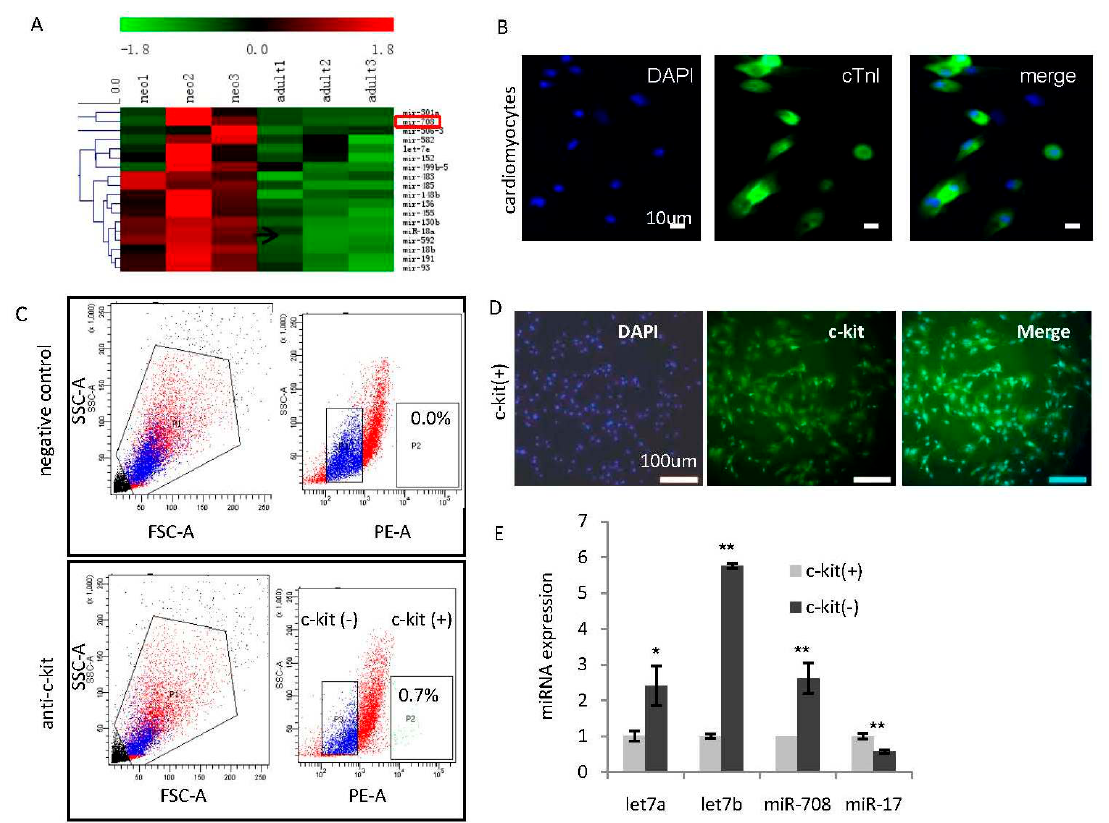
Figure 1. miR-708 is enriched in non-progenitor cardiomyocytes of neonatal rat. ( A ) miRNA profiling analyses between three neonatal and three adult heart tissues in rat identified a subset of miRNAs with higher expression in the neonatal hearts compared to adult hearts including miR-708 which is highlighted with red box; ( B ) Immunofluorescence staining of cardiomyocytes-specific marker cardiac troponin I (cTnI) in cardiomyocytes isolated from fresh heart tissues of neonatal rat; ( C ) FACS analysis isolated c-kit(+) cells from fresh hearts of neonatal rat; ( D ) Immunofluorescence staining of the isolated c-kit(+) cardiac stem cells (CSCs)/cardiac progenitor cells (CPCs); ( E ) A miRNA quantitative analysis demonstrated higher expression of miR-708, let-7a, let-7b and lower expression of miR-17 in c-kit( − ) non-progenitor cardiomyocytes than c-kit(+) progenitors. Data are mean ± SEM ( n = 3). * p < 0.05, ** p < 0.01.